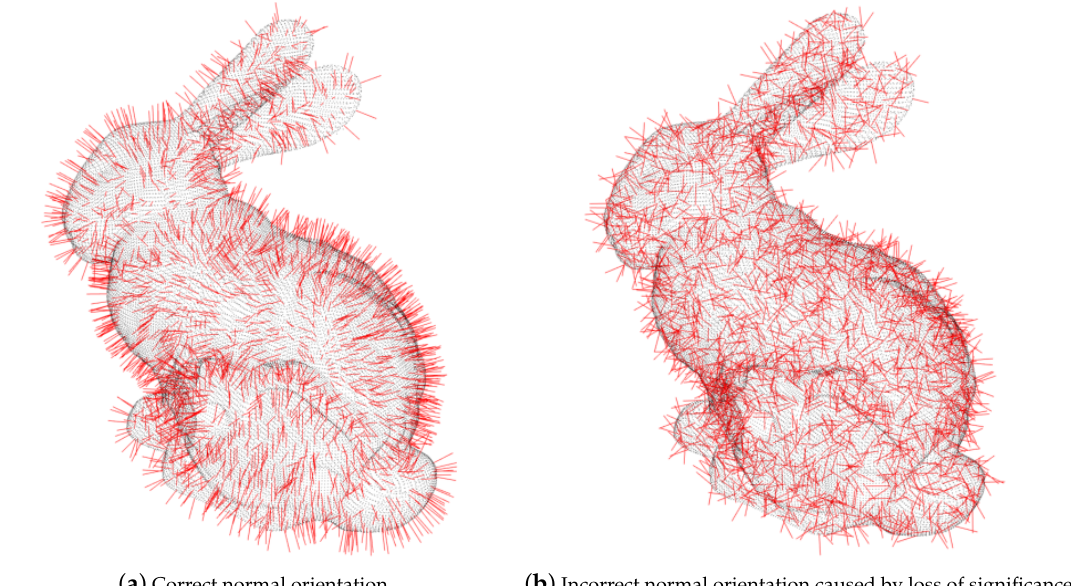
Figure 1. Demonstration of how loss of significance occurs when a cloud is pushed far from the origin of its coordinate system, and the effect this has on point normal